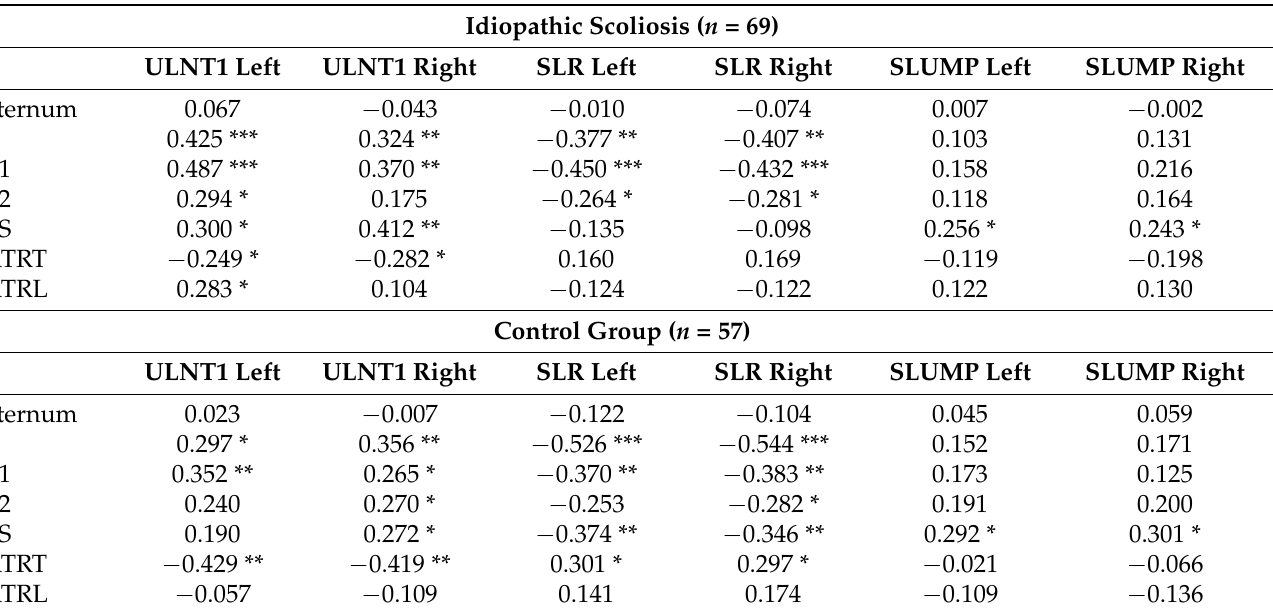
Table 4. Correlations between neurodynamic tests and postural parameters in adolescents with idiopathic scoliosis (IS) and the control group